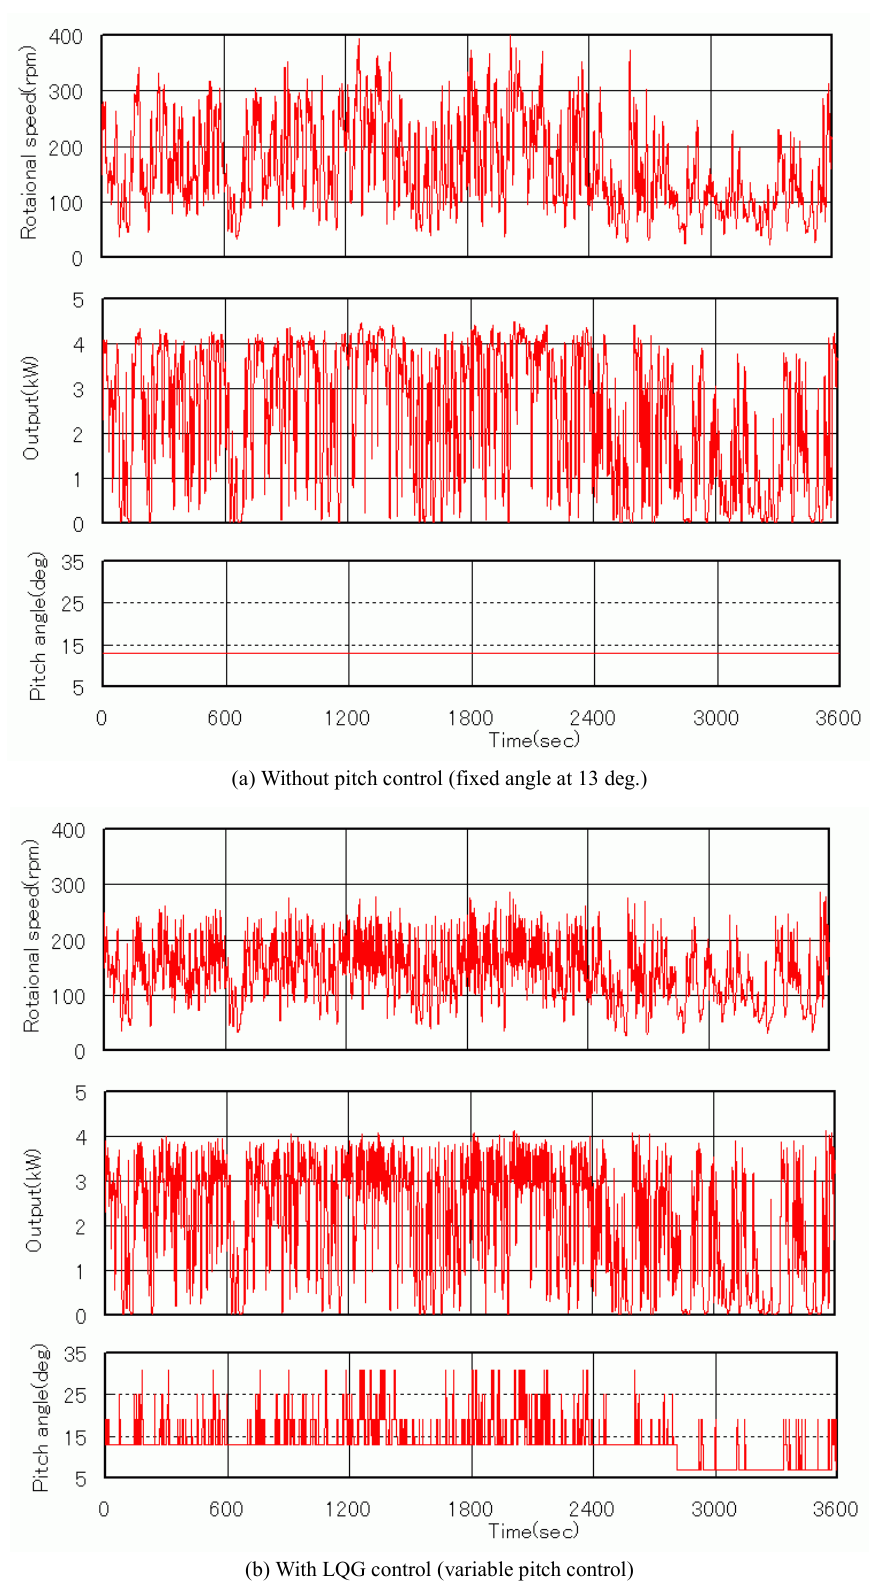
Figure 7 Simulation results using wind data of